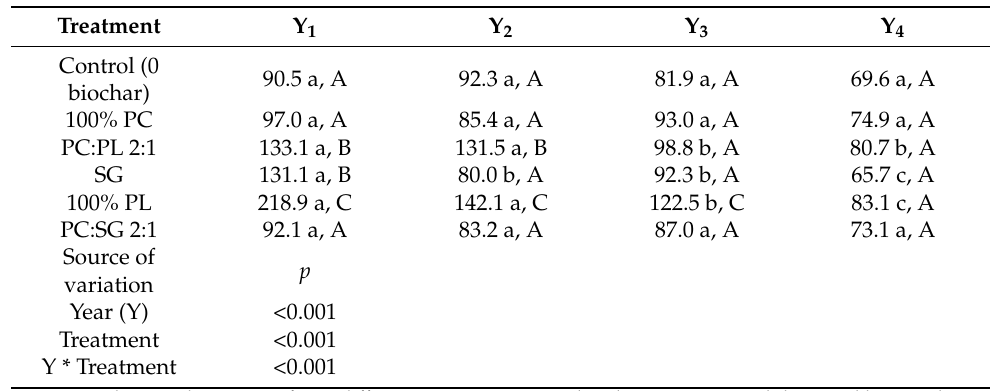
Lower-case letter indicates significant differences among mean values between years, while capital letter indicates